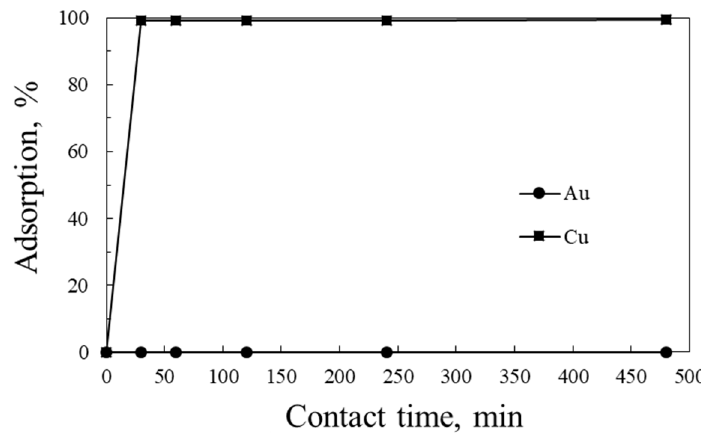
Figure 7. Adsorption efficiency of Au, Cu as a function of contact time (initial pH, ~9.5; dosage, 10 g/100 mL; temperature, 25 ℃ ; contact time, 8 h; agitation speed, 150 rpm).